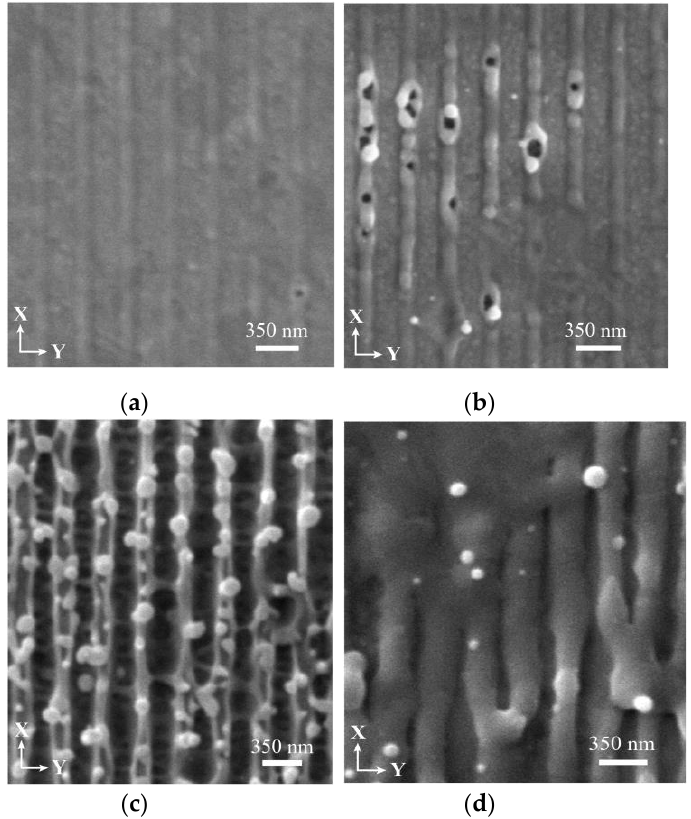
Figure 2. Surface topography obtained on gold after single pulse irradiation with a 350-nm period. ( a ) Surface swelling at 100 mJ/cm², ( b ) void formation at 150 mJ/cm², ( c ) wall formation at 200 mJ/cm², ( d ) broad melting at 350 mJ/cm².